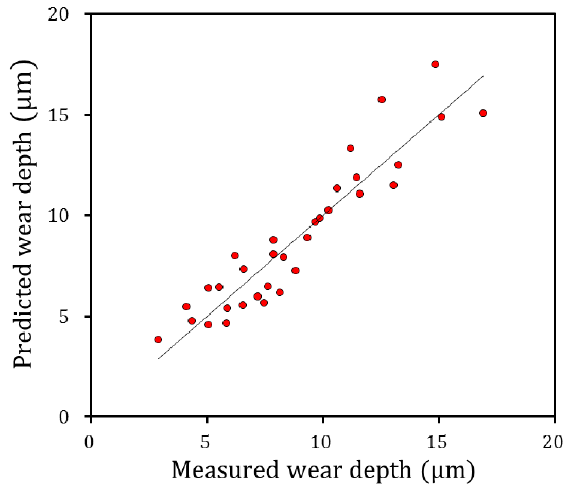
Figure 9. Prediction accuracy of the wear depth calculated by the power-law-type equation.